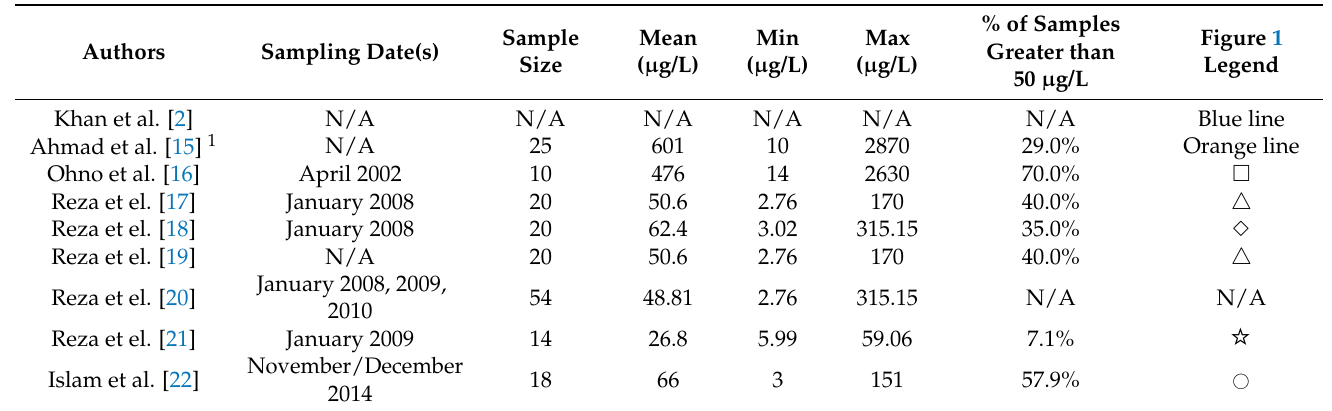
Table 1. Summary of previous scientific literature data.